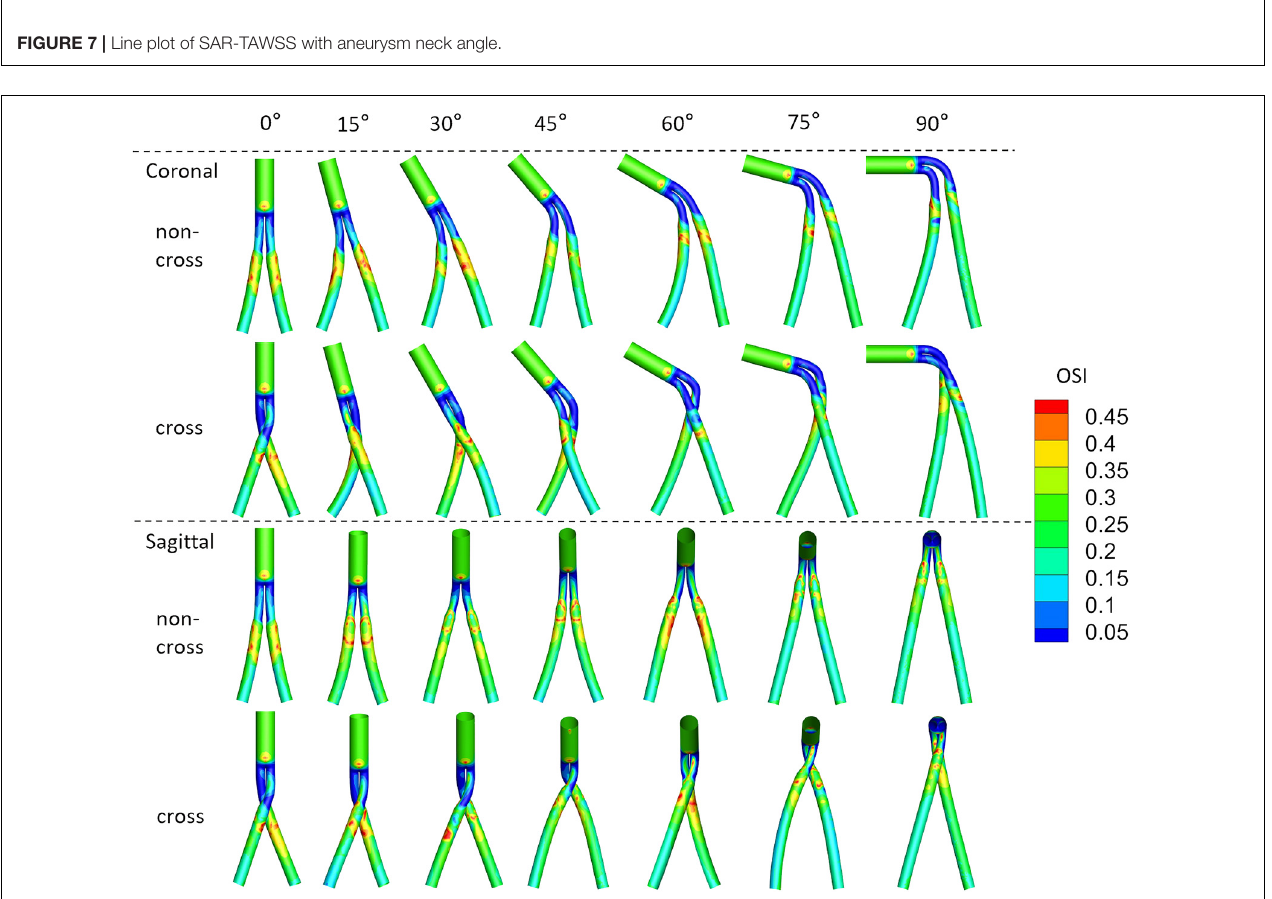
FIGURE 8 | Contours of OSI, with different colors to represent the magnitude of OSI.